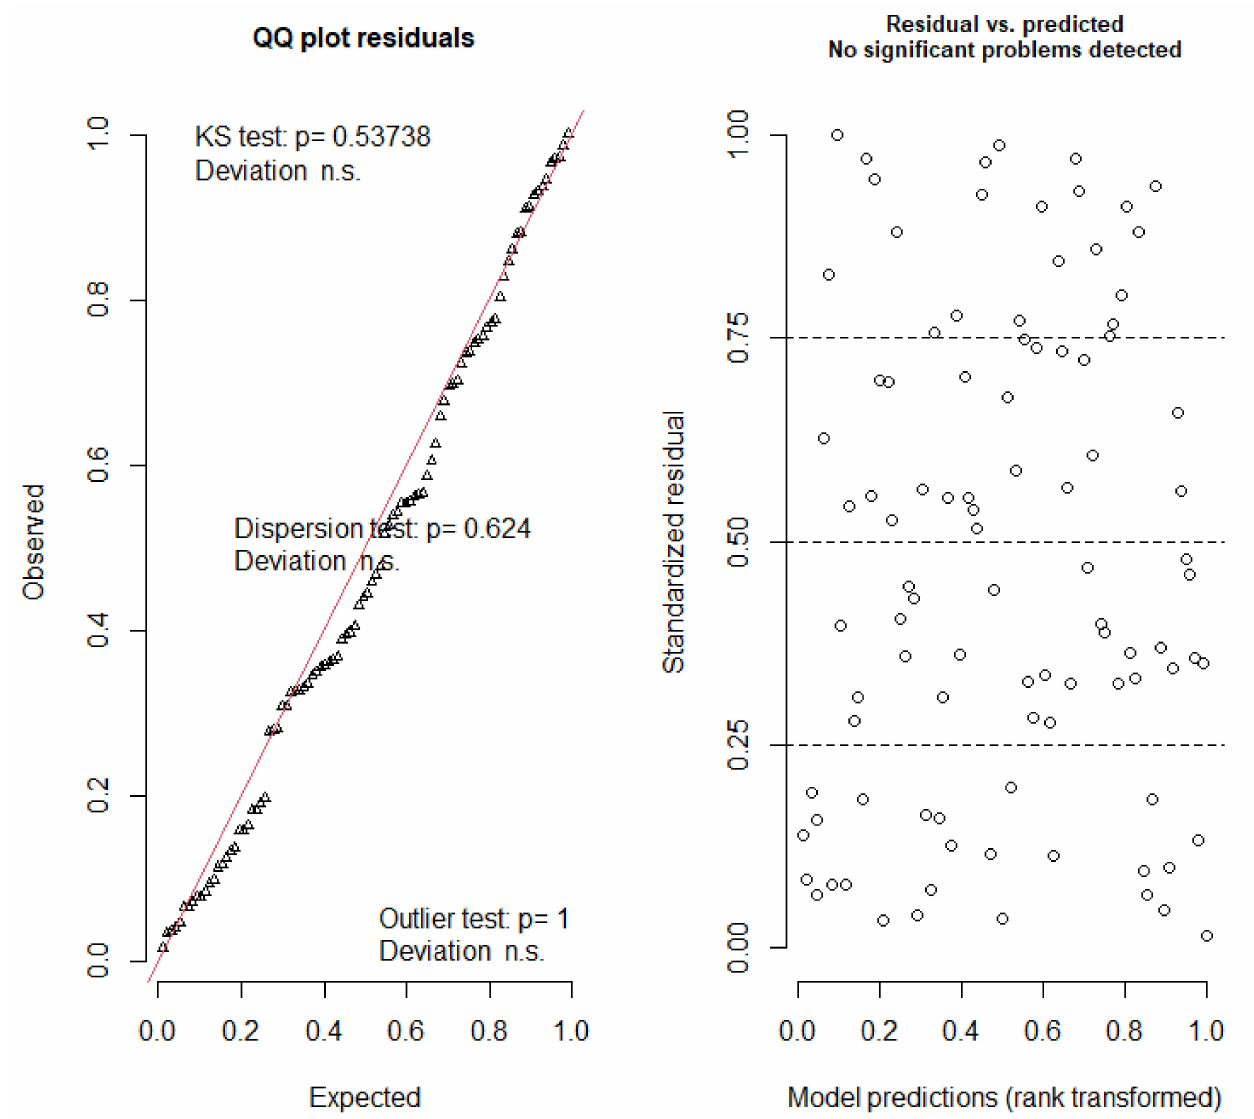
Figure A1. Q-Q plot of and the residuals versus the predicted for the Mean catch model of Lucilia cuprina